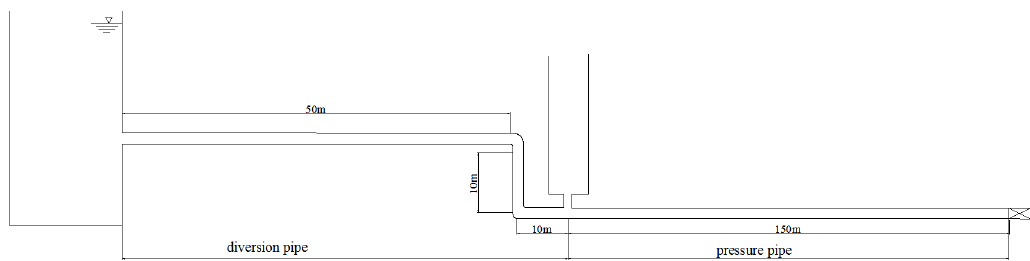
Figure 7. Schematic of water conveyance system with surge chamber.